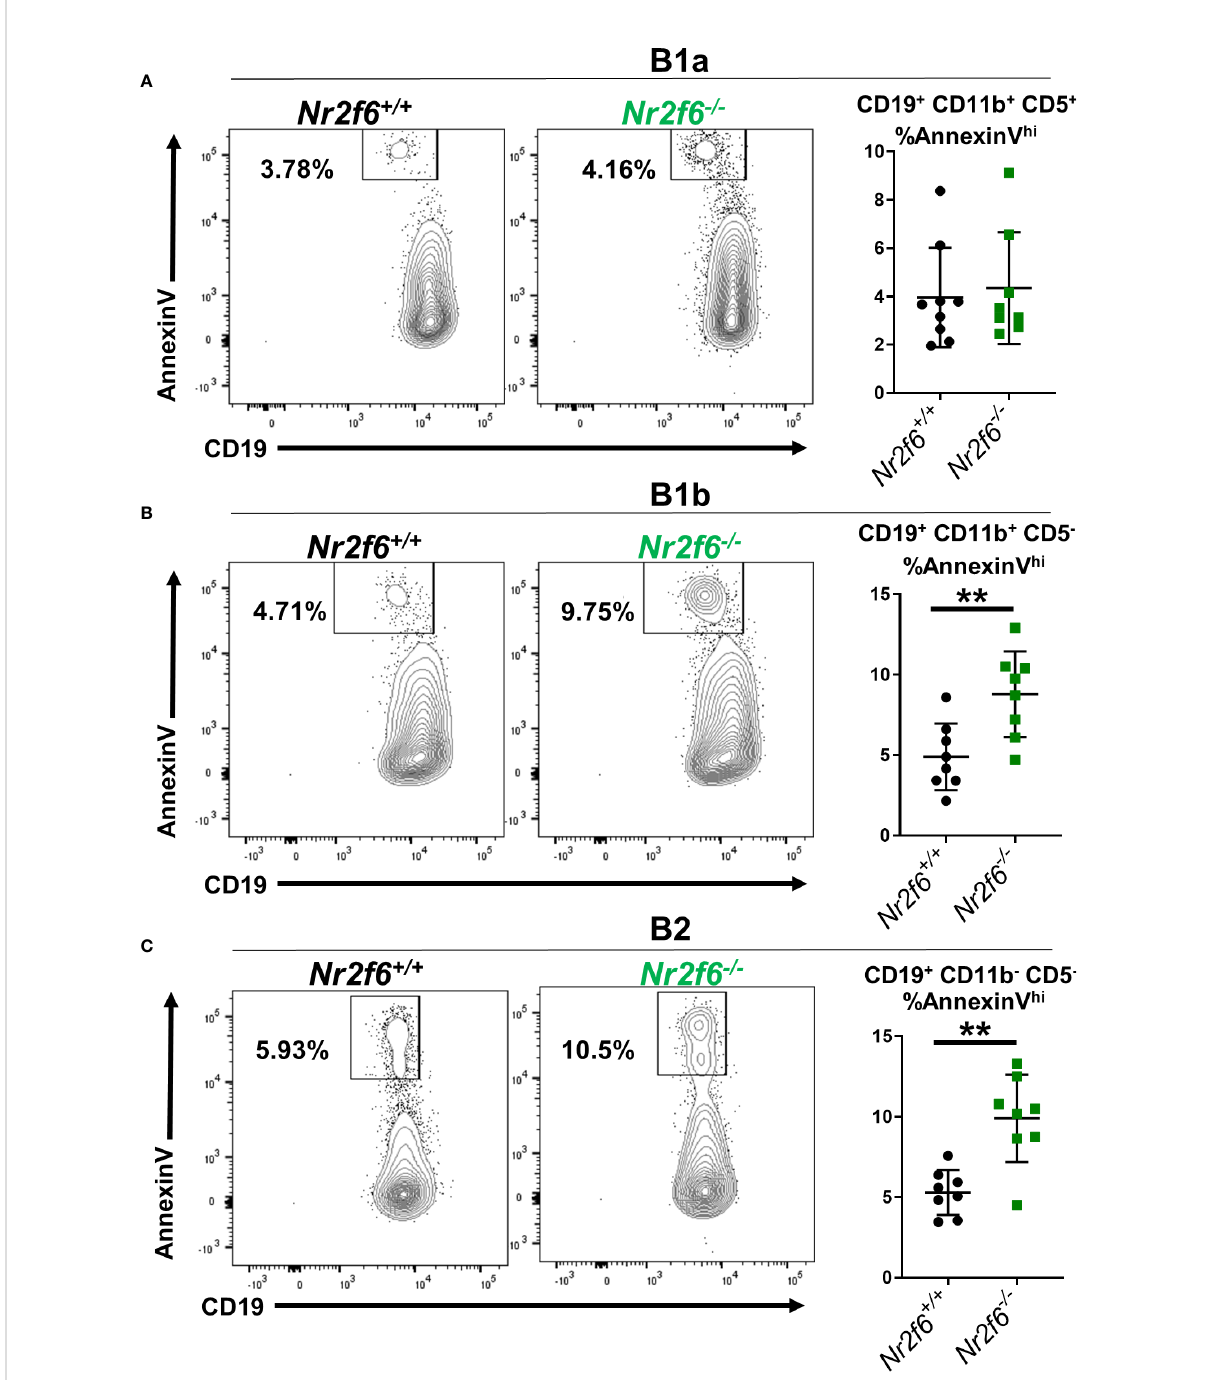
FIGURE 7 The frequency of Nr2f6 -/- peritoneal B1b and B2 cells staining for AnnexinV is higher relative to Nr2f6 +/+ peritoneal B cells. Peritoneal cells were isolated and B cell populations de fi ned by CD5, CD11b and CD19 expression. The frequency of AnnexinV staining within (A) B1a, (B) B1b and (C) B2 cells is displayed. FACS panels show representative FACS plots and graphs (right side) show the frequency of AnnexinV staining from all experiments performed. Each data point represents one mouse. The experiment was performed three times with at least two mice of each genotype per experiment. Statistical signi fi cance was determined using a two-tailed student t-test, signi fi cant p-values are displayed as